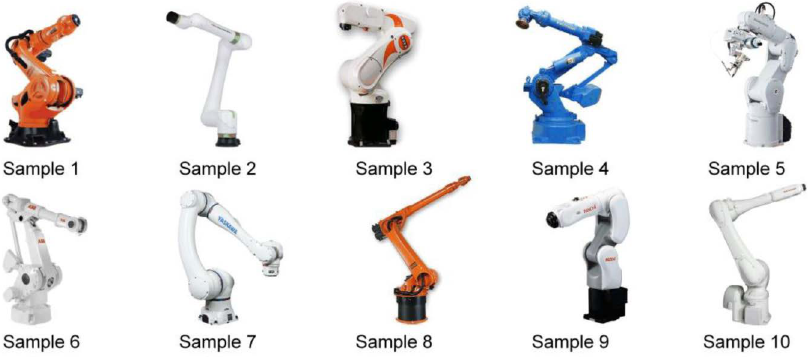
Figure 2. 10 industrial robot sample